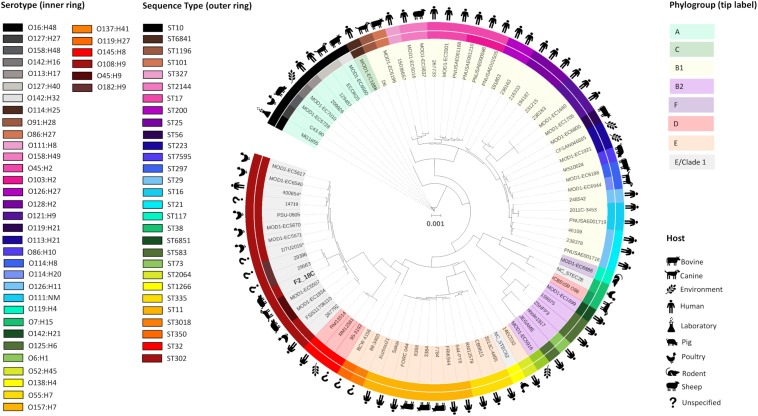
Maximum-likelihood phylogenetic tree showing genetic relatedness of E. coli strain F2_18C. Phylosift, FastTree2, FigTree and iTOL were used to generate and visualize a maximum-likelihood phylogenetic tree, rooted on E. coli laboratory strain MG1655. A total of 91 E. coli strains were used, including all publicly available E. coli ST302 strains. The colored bands that form the outer ring relate to each strains ST and the second ring refers to serotype. Icons around the circumference refer to the host or environment from which the strains were isolated. Shading over tip labels indicates phylogroups. F2_18C is shown in bold. ∗Indicates an abbreviated strain name: 400654∗ = Escherichia_coli_400654-sc-2012-01-13T20:11:31Z-1332520; DTU2016∗ = DTU2016_ 526_ PRJ1050_ Eschericha_coli_Isol133.